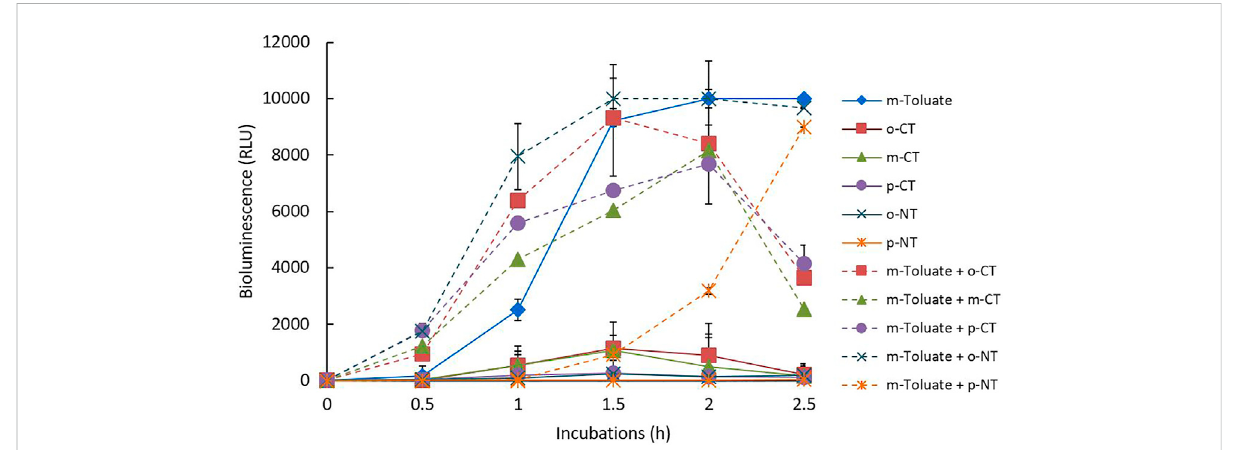
FIGURE 5 Representativeresultsofthebioluminescenceactivitiesofindividualinducersandbinarymixturesof m -toluate,CTs,andNTsamongthetested 40 mixture combinations during 2.5 h incubation periods; individual inducer (solid line) and mixtures (dotted